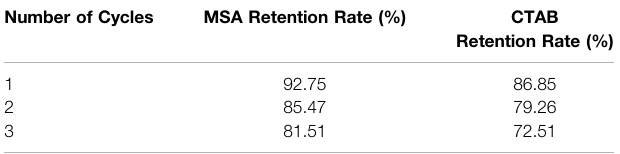
TABLE 3 | Related parameters of recycled cleaning fracturing fl uids. Number of Cycles